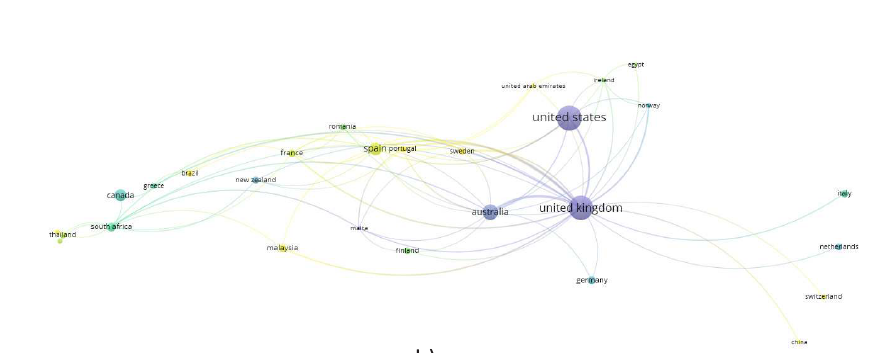
b) Figure 6. Overlay visualization map of country citations measurement of research on public service marketing according to the Scopus